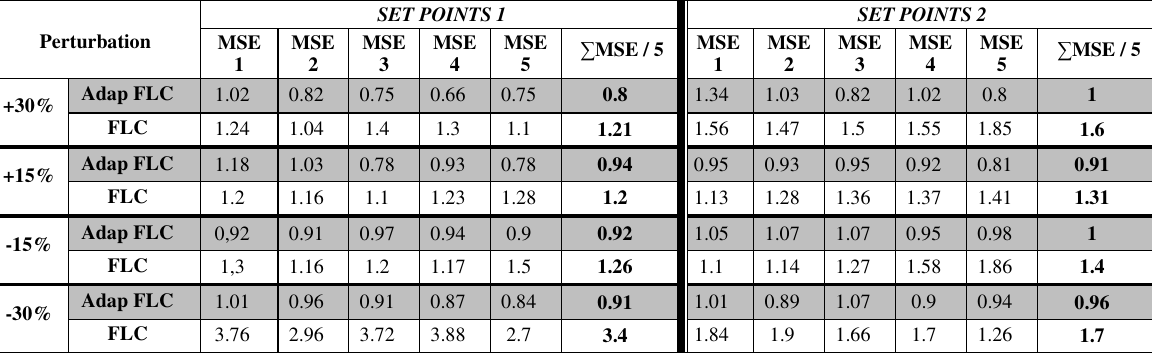
Table 7. The MSE obtained under several types of perturbations.